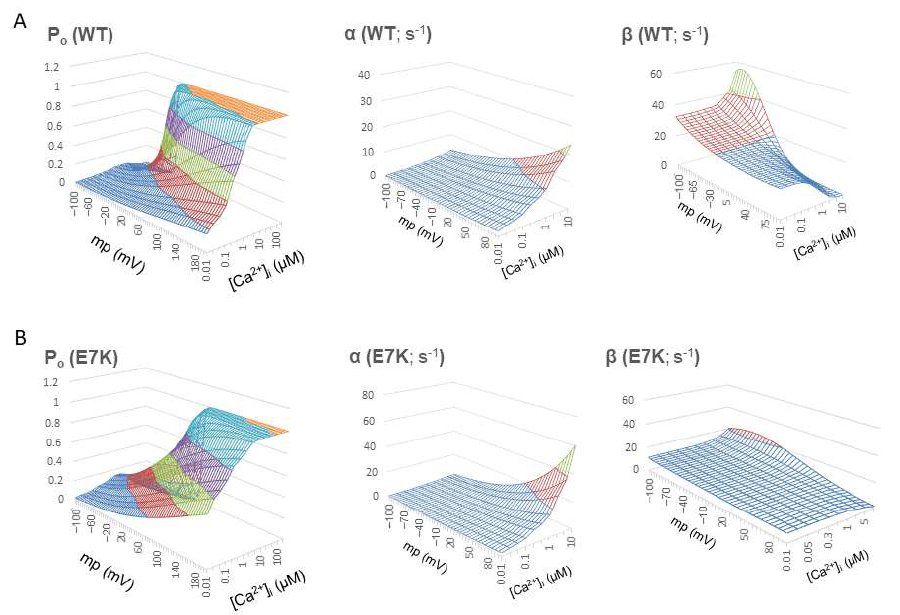
Figure 3. Voltage- and Ca 2+ -dependent profiles of Po, α and β . P o , α and β were recalculated over wide ranges of V m and [Ca 2+ ] i by using the mathematical expressions of α and β shown above. For wild-type TRPM4, similar mathematical expressions for α and β which had been obtained from wild-type TRPM4 expressing HEK293 cells [13] were used to calculate P o , α and β . A and B; surface plots of P o , α and β (from left to right) for wild-type TRPM4 channel against two variables V m and [Ca 2+ ] i ( A ) and those for E7K-mutant TRPM4 channel ( B ). Note that P o contour is less steep for E7K mutant with increased voltage-dependence of α and prominently decreased voltage and Ca 2+ dependency of β which stay low over the whole V m and [Ca 2+ ] i ranges. These results indicate a preferred sojourn in the open state of E7K channel due to accelerated C-O transition and greatly suppressed O-C